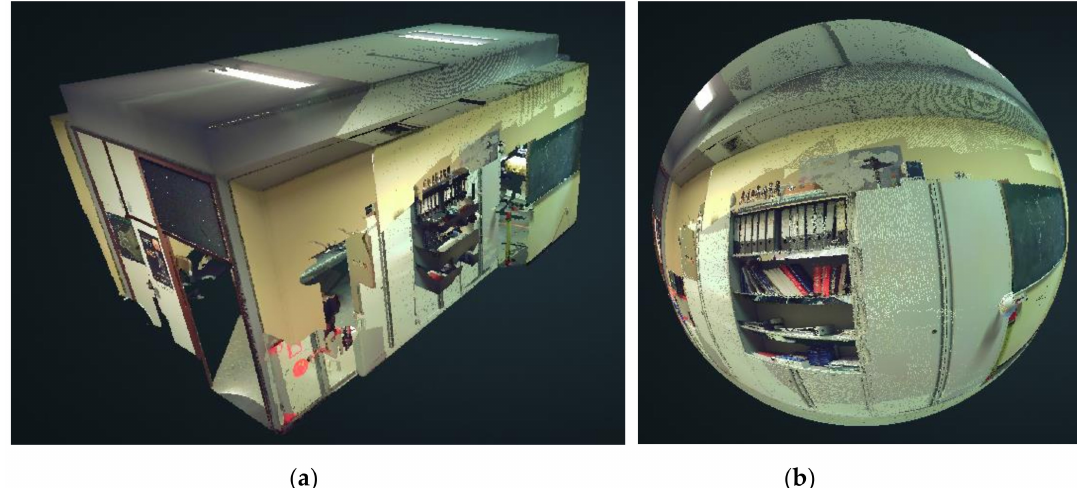
Figure 3. Visualisation on Potree: ( a ) the initial point cloud; ( b ) result of the spherical projection. Adapted from ref.